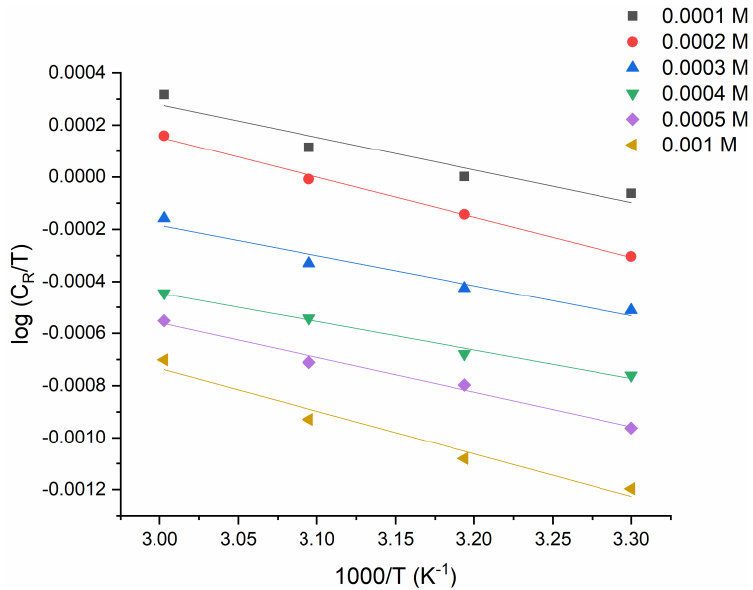
(cid:110) (cid:111) 𝐶 𝑅 C R } versus 𝑖 for tested metal with differ- versus i for tested metal with different T T 𝑇 𝑇